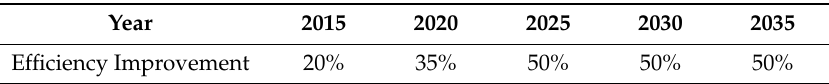
Table 5. Efficiency Improvement Scenario for Alt-2.